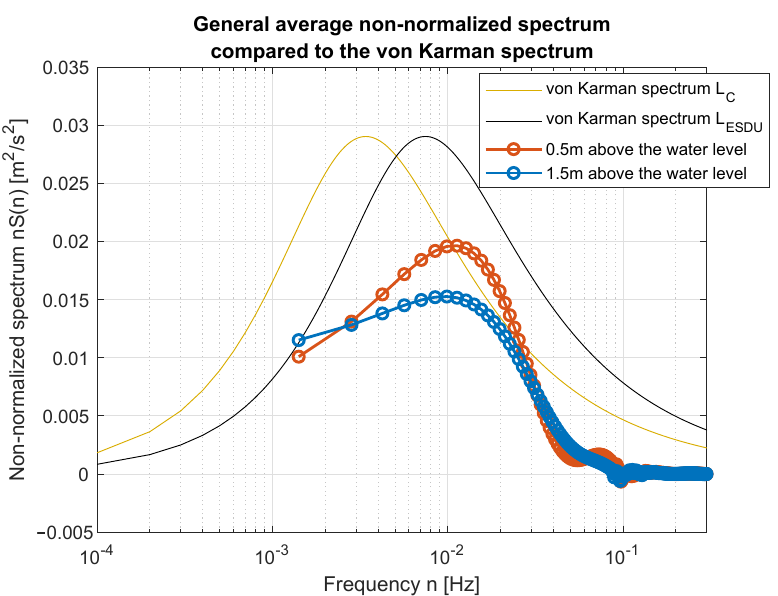
Figure 21. Medium-weak wind (5 BFT in ship scale) compared to Karman